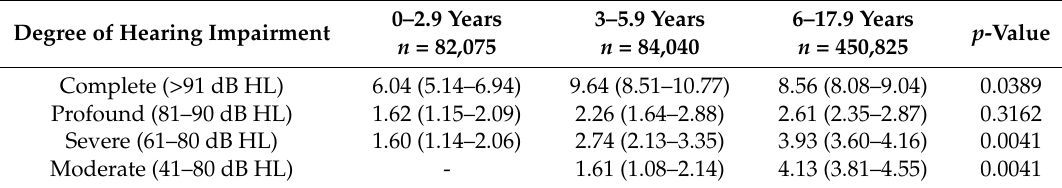
Table 3. Prevalence of hearing impairment by age group and degree of hearing impairment (per 10,000 people).